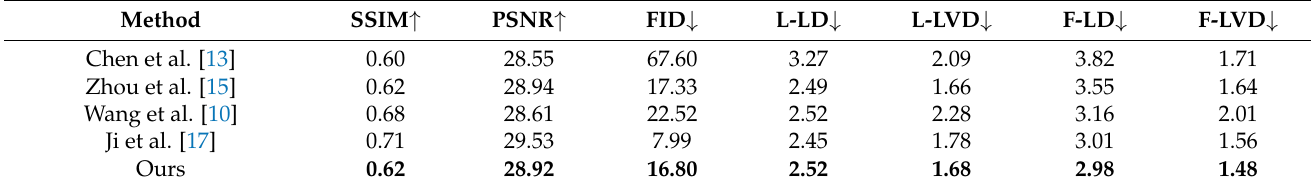
Table 1. Quantitative comparison with state-of-the-art methods. Calculation of landmark accuracy and video quality by comparing the results of different methods with real data. L- represents the lip area and F-represents the face